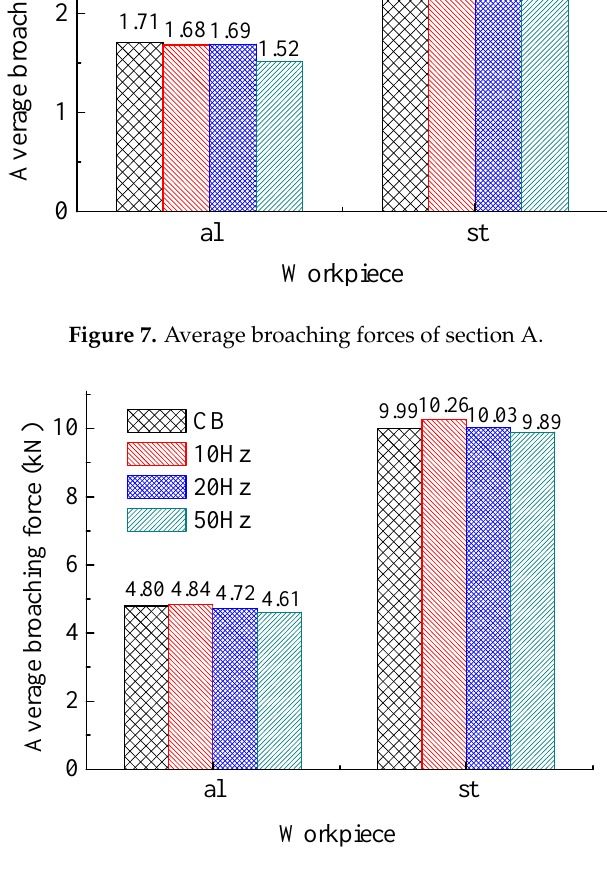
Figure 8. Average broaching forces of section B.